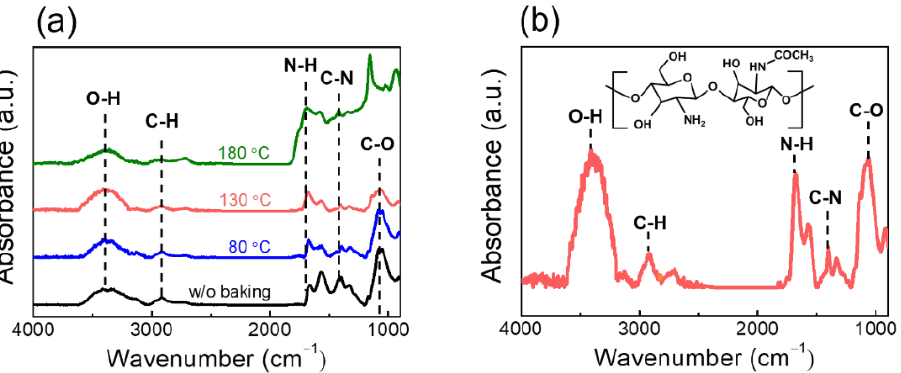
Figure 2. ( a ) Fourier transform infrared spectroscopy (FT-IR) of the chitosan electrolyte film with varying baking temperature and ( b ) 130 ◦ C baking condition. Inset: Molecular structure of the chitosan electrolyte.